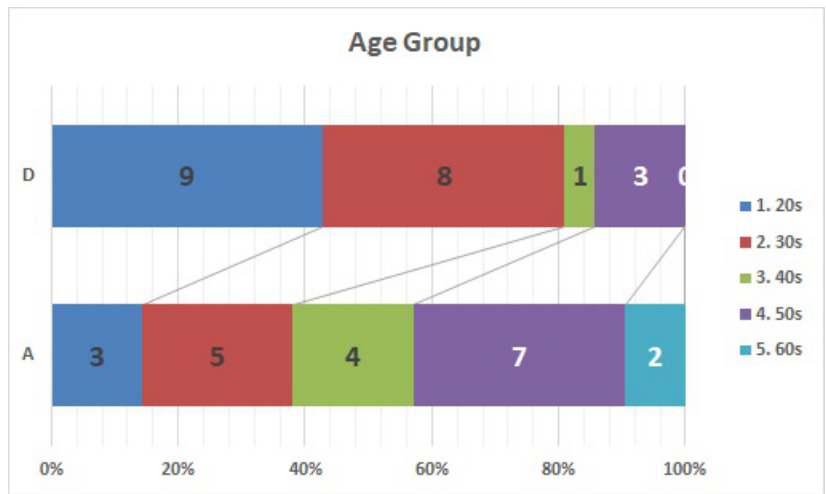
Figure 2. Age Group: Respondents in facility D tended to be younger than those in facility